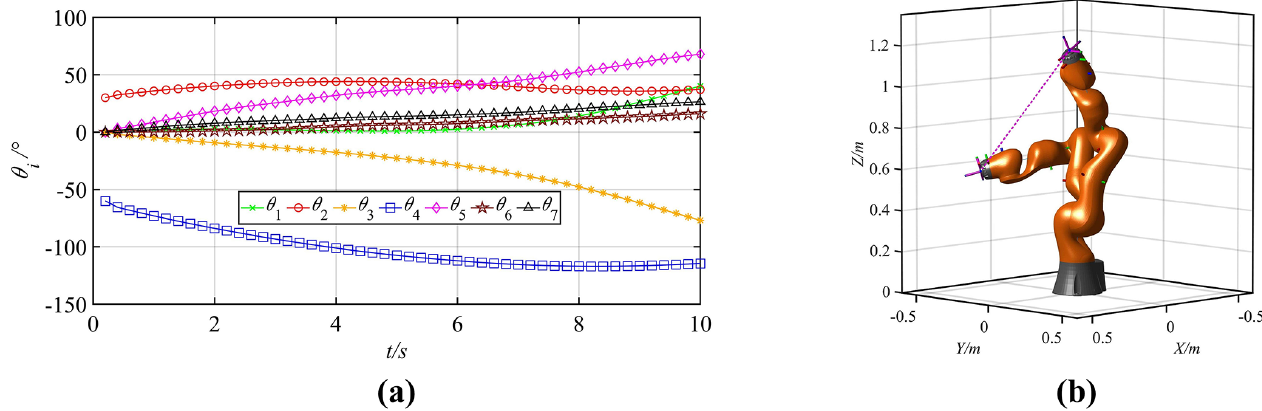
Figure 16. Motion curves of the joints and the manipulator ( k 2 = 0 . 5, k 1 = k 3 = k 4 = k 5 = k 6 = k 7 = 1 . 0). (a) Joint motion curves. (b) Tra- jectory of the manipulator.